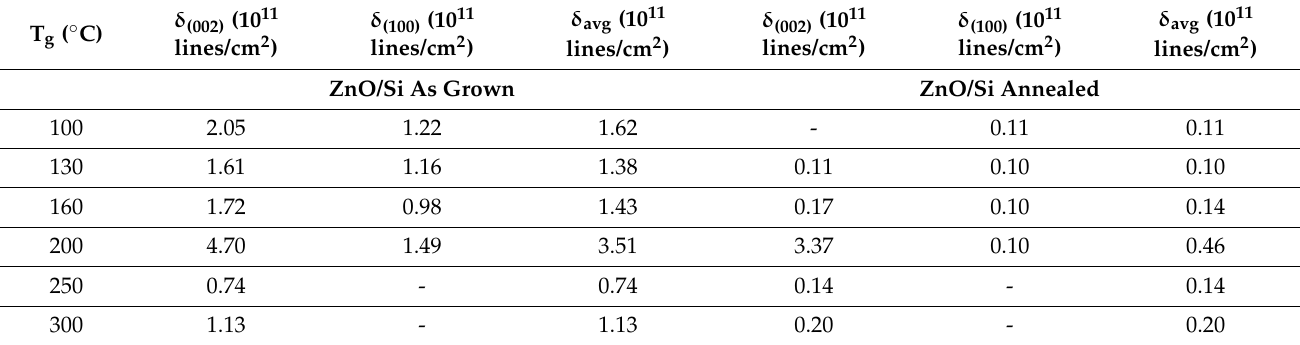
Table 2. Dislocation density ( δ ) for as grown and annealed ZnO/ a -Al 2 O 3 films calculated based on the XRD data. T g ( ◦